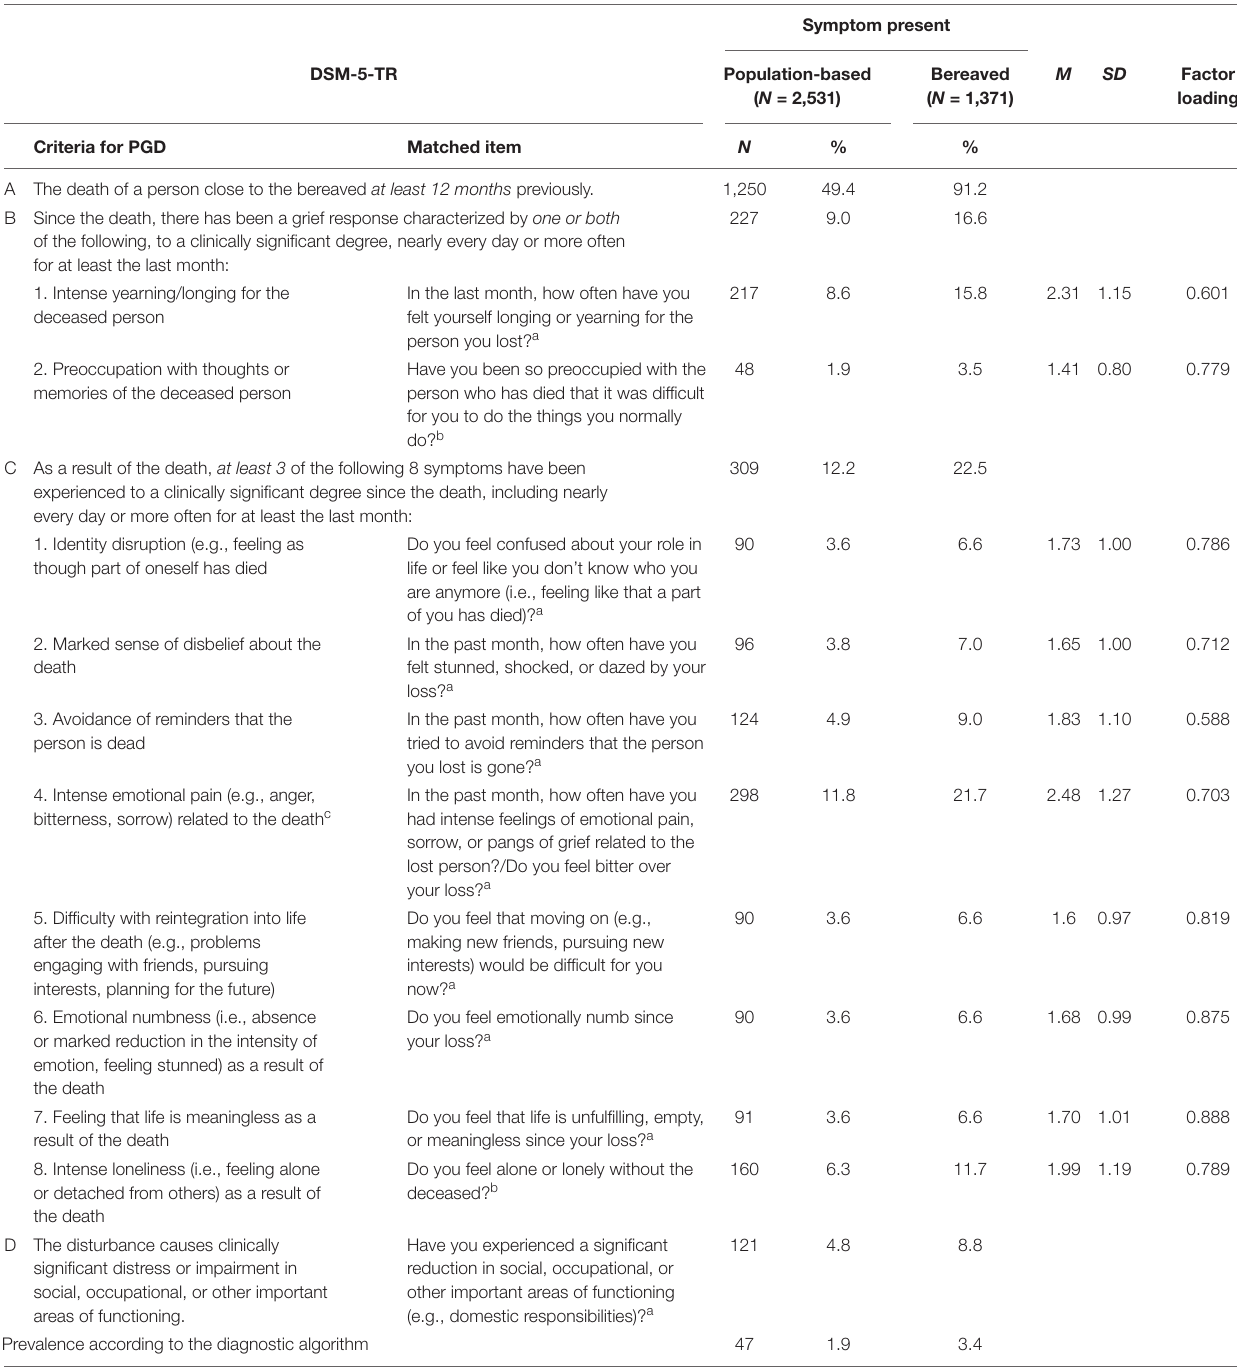
TABLE 2 | Frequency of occurrence of single symptoms of